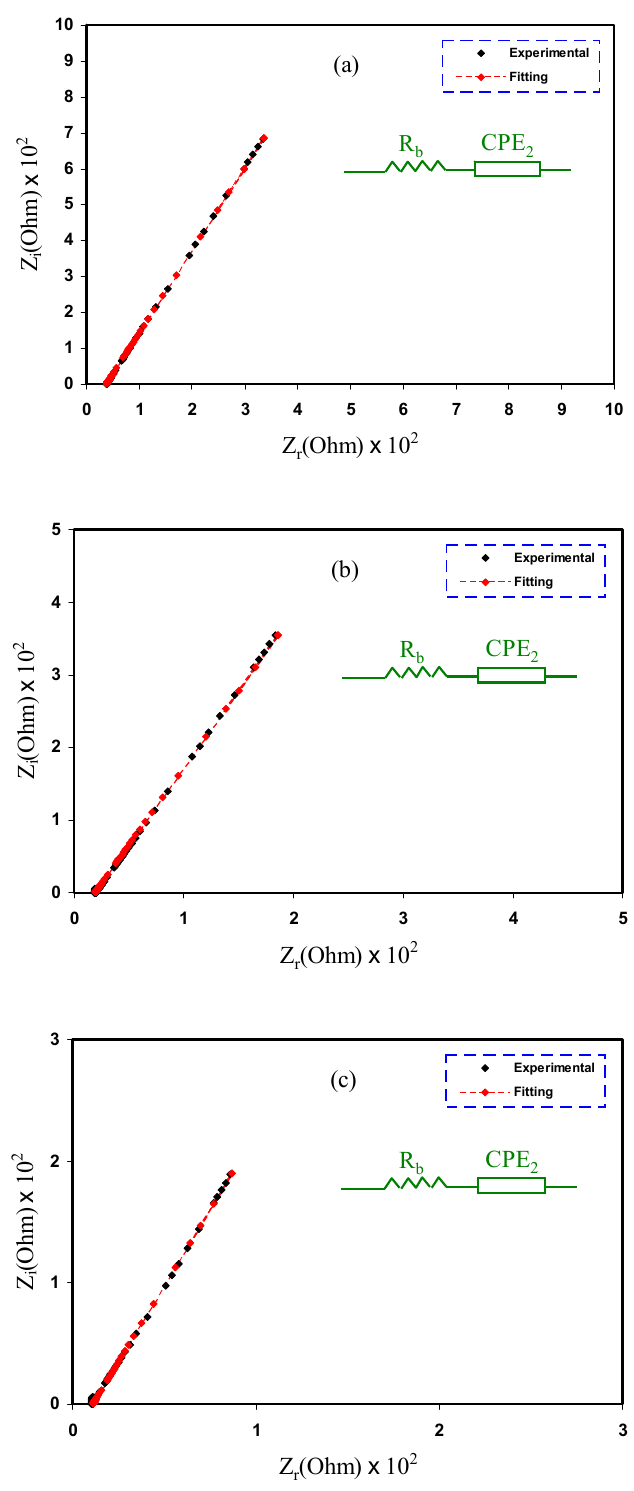
Figure 3. EIS spectra of ( a ) MDLG1, ( b ) MDLG2, and ( c ) MDLG3 electrolytes .